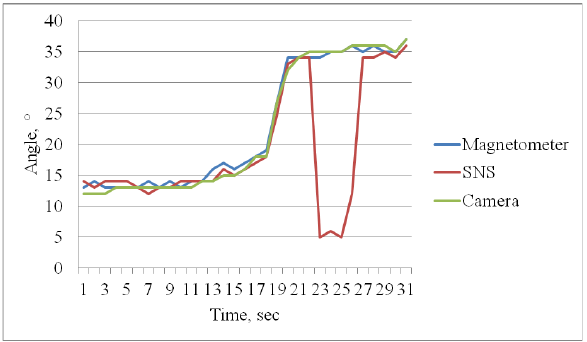
Fig. 4. Image of cancel at the satellite navigation system